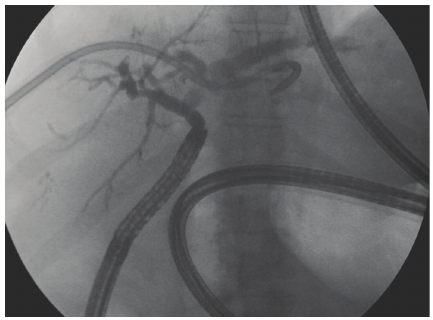
Figure 2: The residual biliary duct was injected and the biliary ducts